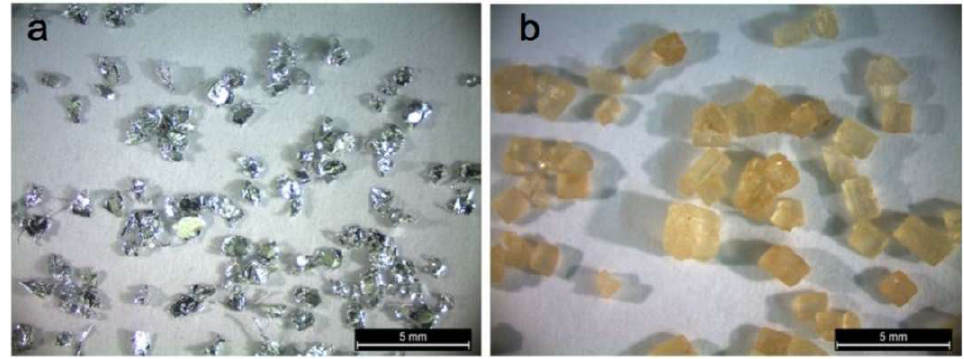
Figure 2. Materials used in the manufacturing process of the open-cell aluminum foam: ( a ) Aluminum flakes, ( b ) saccharose particles.